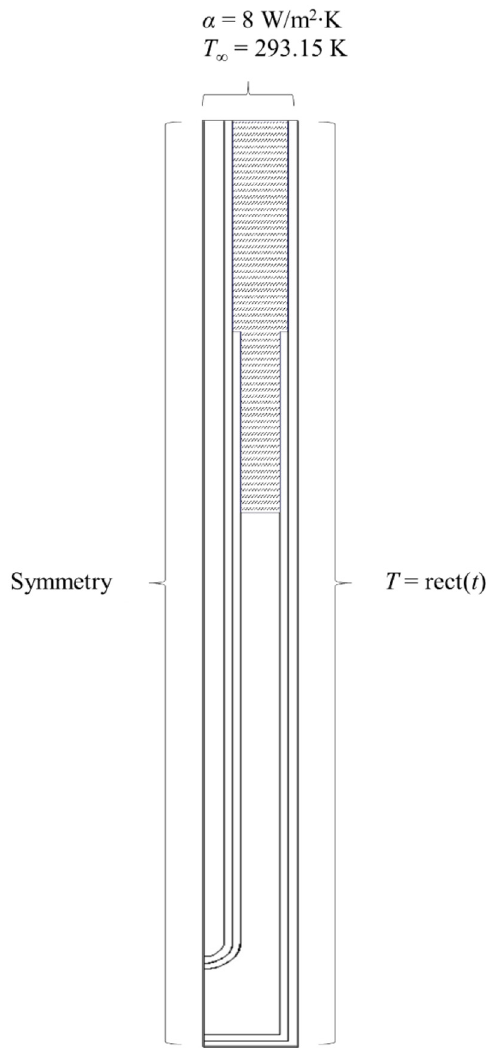
Fig. 5. Fixed point cell boundary